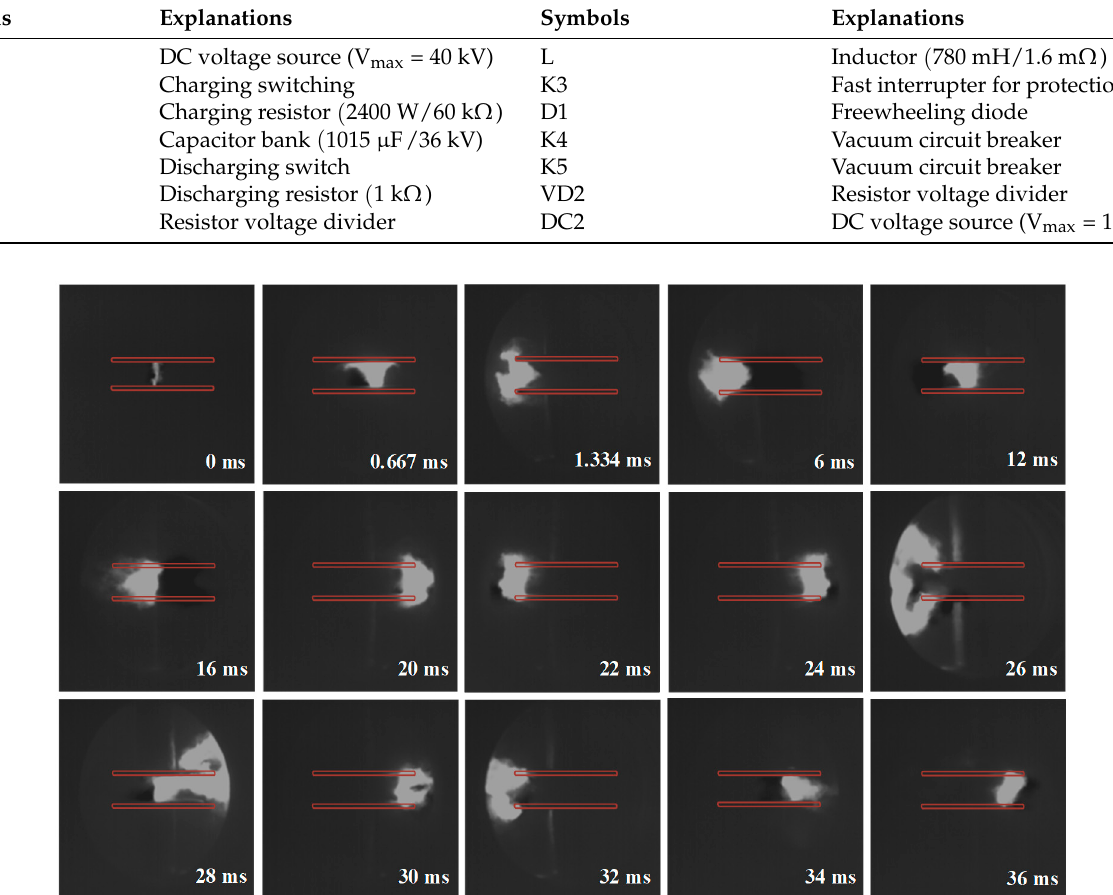
Figure 6. The arc morphology photographed during the 36 ms arcing process for a test case with a peak current of 33 kA.